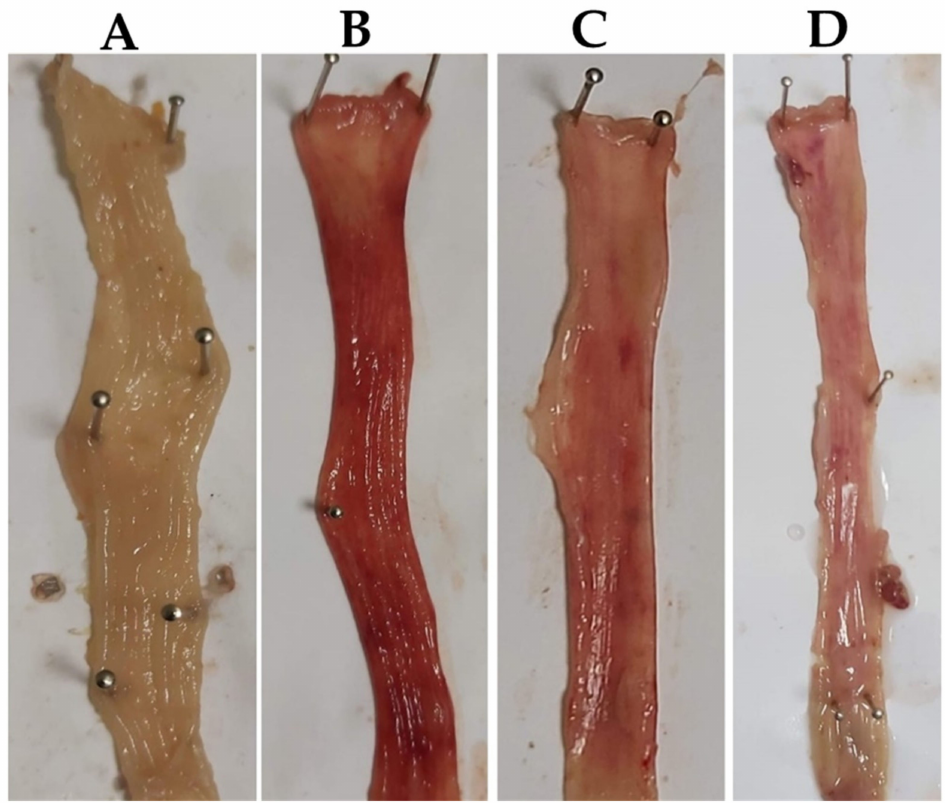
Figure 2. The Gross morphological depiction of colons. ( A ) Normal control, ( B ) acetic acid-treated, ( C ) SA (40 mg/kg)-treated and ( D ) PDRL (2 mg/kg)-treated